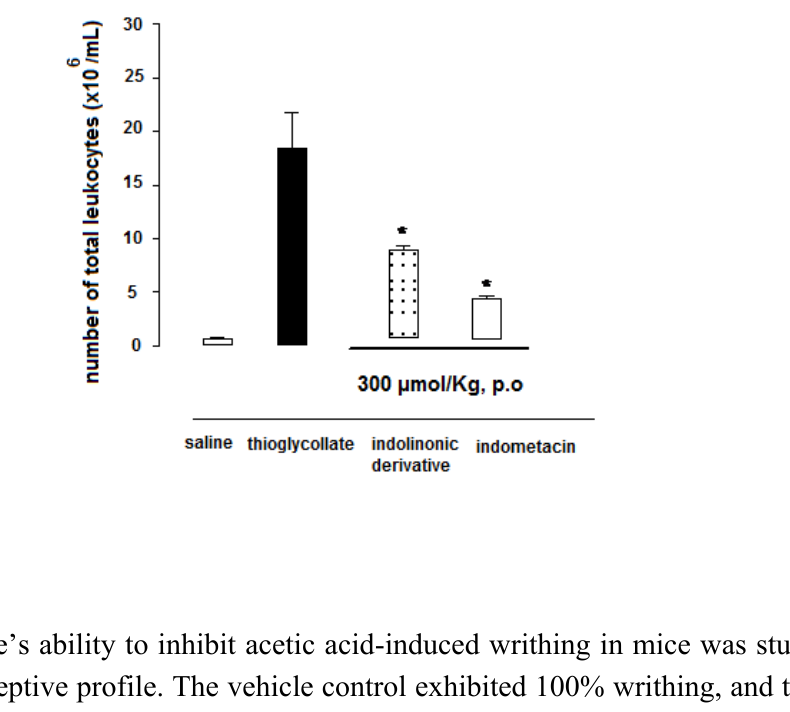
Figure 2. Effect of lactam derivative 1 and indomethacin on cell migration in peritonitis 3% thioglycollate-induced in mice. All compounds were administered p.o at a dose of 300 µmol/kg. Mice were killed at the time-point of 4 h after % thioglycollate-induced peritonitis. Total cell migration was counted using a Neubauer chamber. Data represent mean ± S.E.M. from at least six animals. * P < 0.01 (ANOVA followed by Dunnett’s